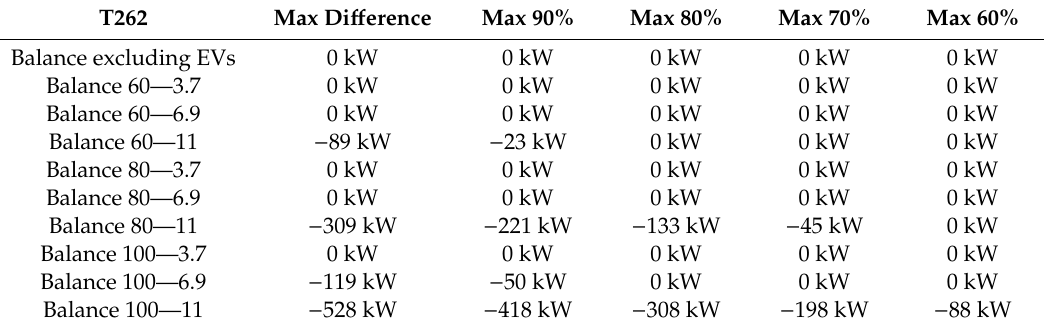
Table 12. Replacement of electric heating by district heating for transformer T262—late night charging.